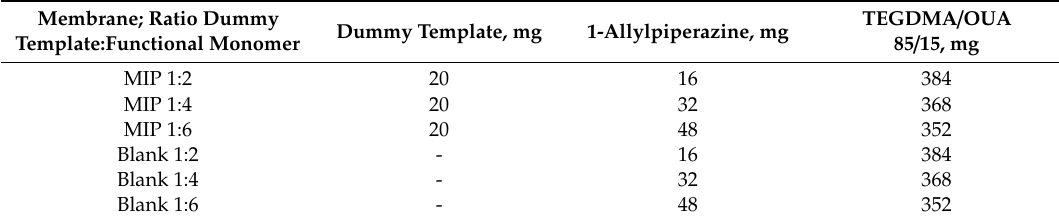
Table 1. Mixture of monomers used for the synthesis of 1-allylpiperazine-containing molecularly imprinted polymer (MIP) and blank polymeric membranes capable of zearalenone binding. *